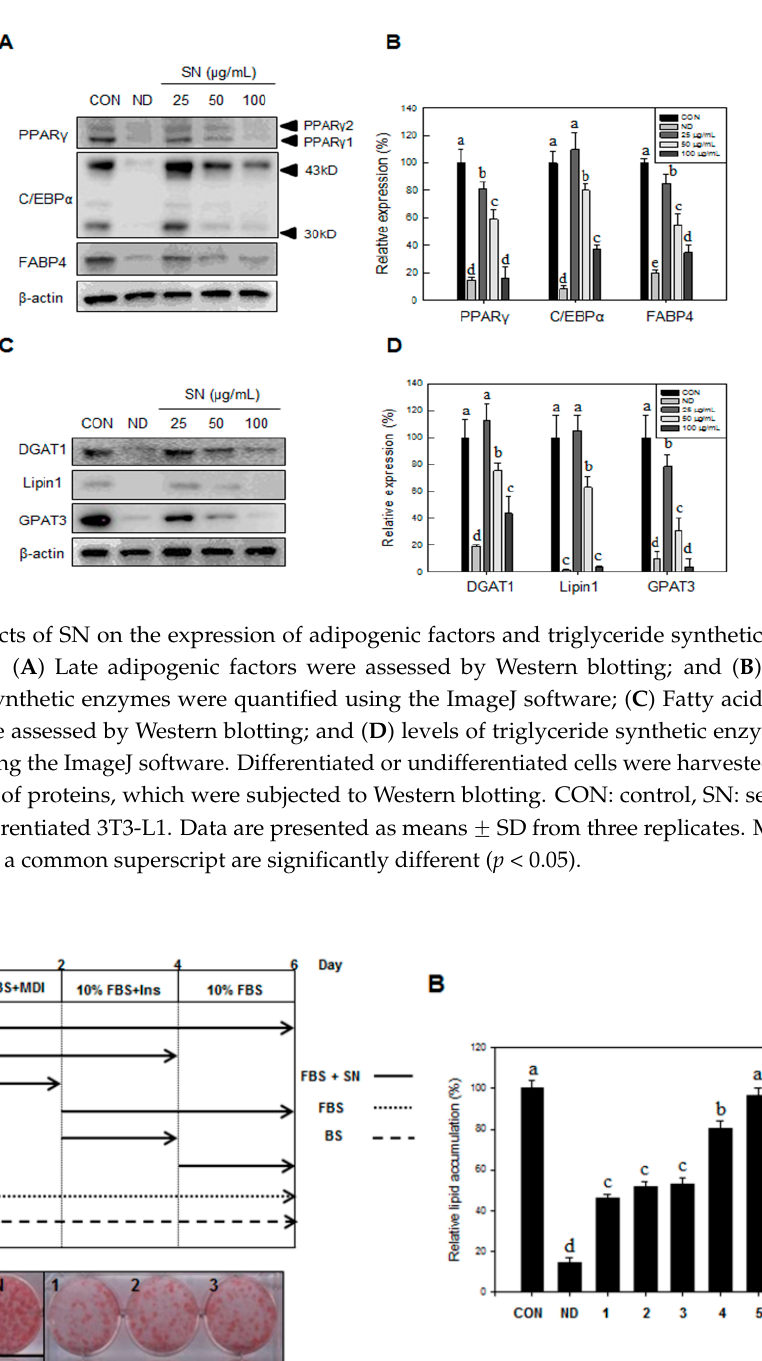
Figure 1. Effects of SN on lipid and triglyceride in adipocyte. Differentiation was induced by incubation with a hormone cocktail in the presence or absence of SN for eight days. ( A ) Cytotoxicity of SN treatment ( B ) After eight days, the cells were stained with Oil red O, which was subsequently eluted in isopropanol and its optical density at 490 nm was measured; ( C ) Triglyceride (TG) accumulation was determined using a TG assay kit (Zen Bio, Inc., Research Triangle Park, NC, USA). CON: control, SN: seapolynol, ND: non-differentiated 3T3-L1. Data are presented as means ± SD from three replicates. Means not designated by a common superscript are significantly different ( p < 0.05).